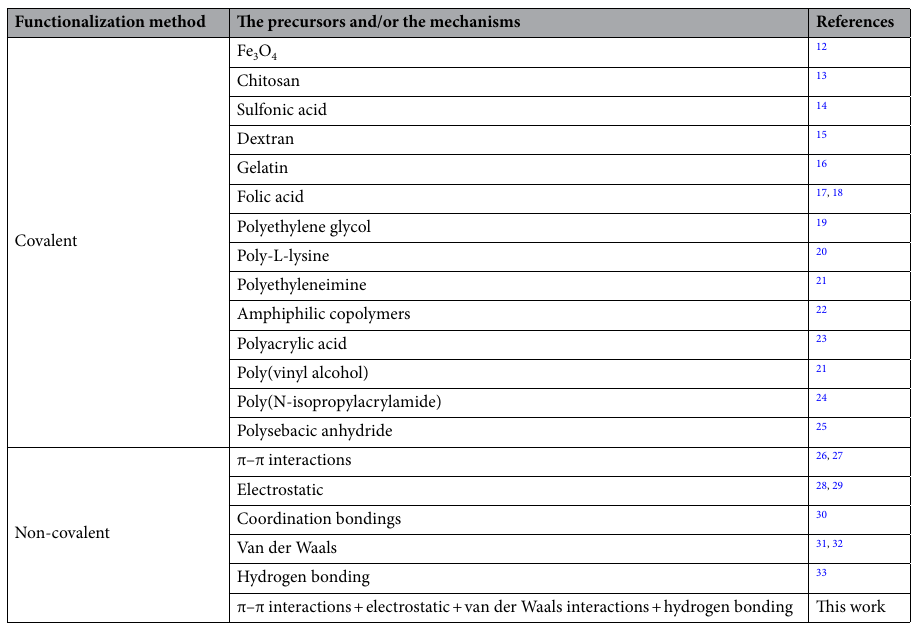
Table 1. A literature survey summary regarding the physical and chemical approaches in order to modify the graphene-based nanomaterials for drug/gene delivery